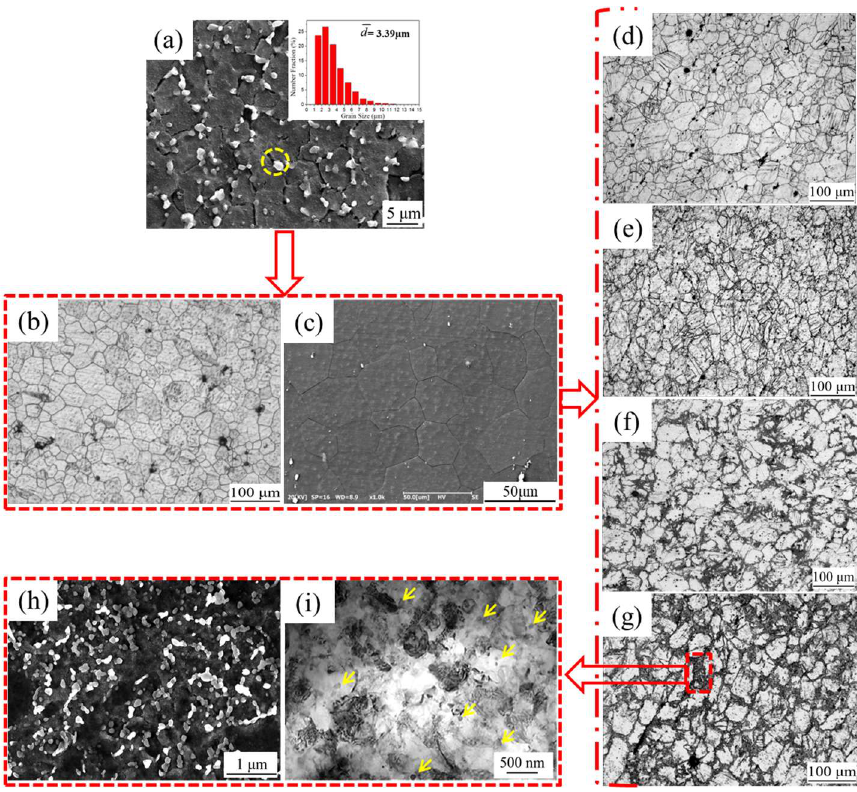
Figure 2. Microstructures of the ( a ) HE alloy [30], ( b , c ) heated HE alloy, ( d ) 20%-HER alloy, ( e ) 40%-HER alloy, ( f ) 60%-HER alloy, and ( g – i ) 70%-HER alloy [30]; ( a , c , h ) SEM image, ( b , d – g ) optical microstructures, and ( i ) TEM image.